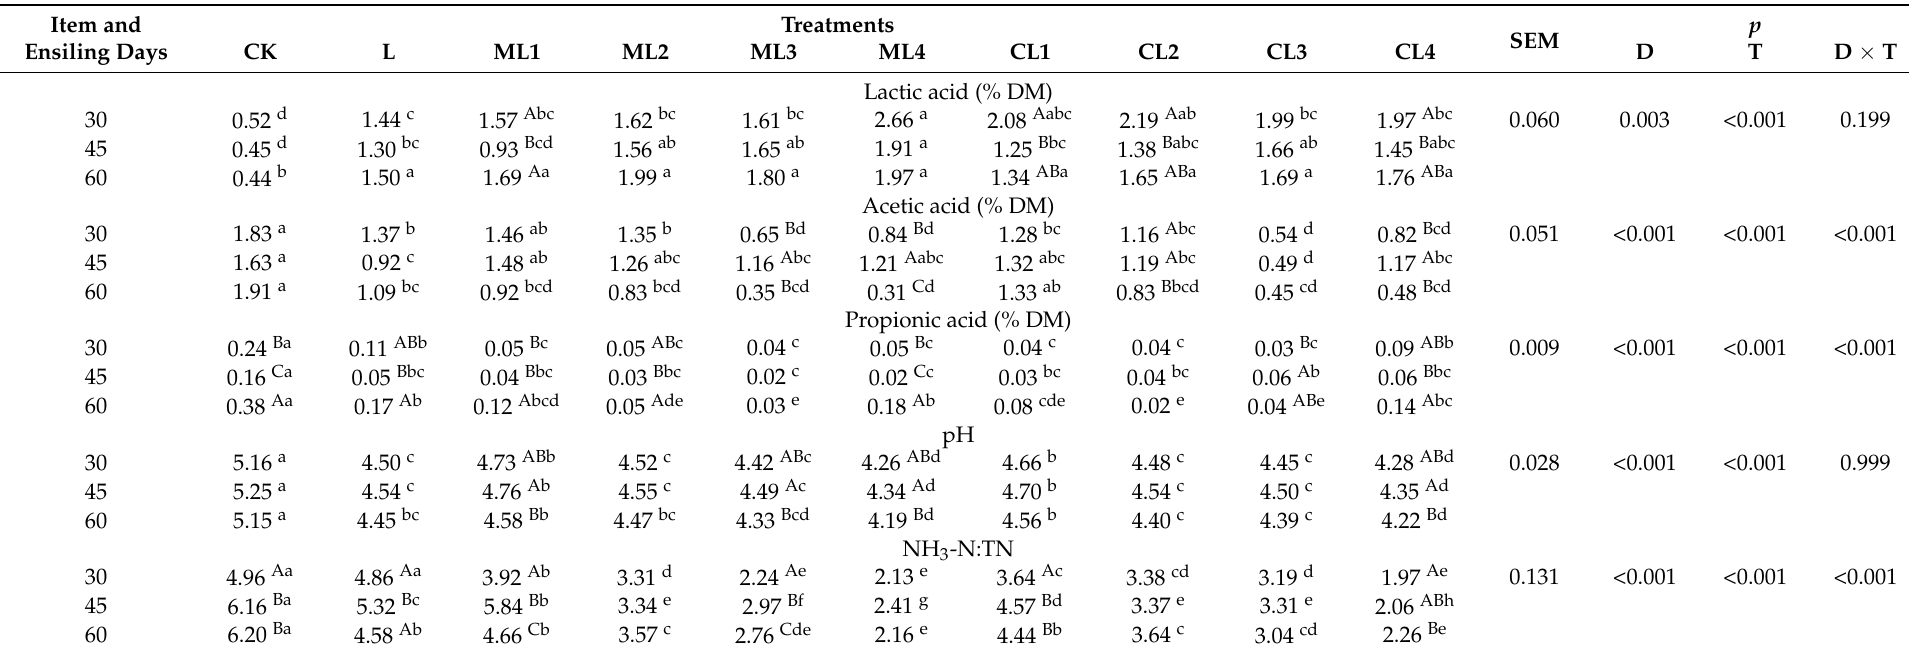
Table 4. Effect of ensiling time and additives on fermentation characteristics of Chamaecrista rotundifolia